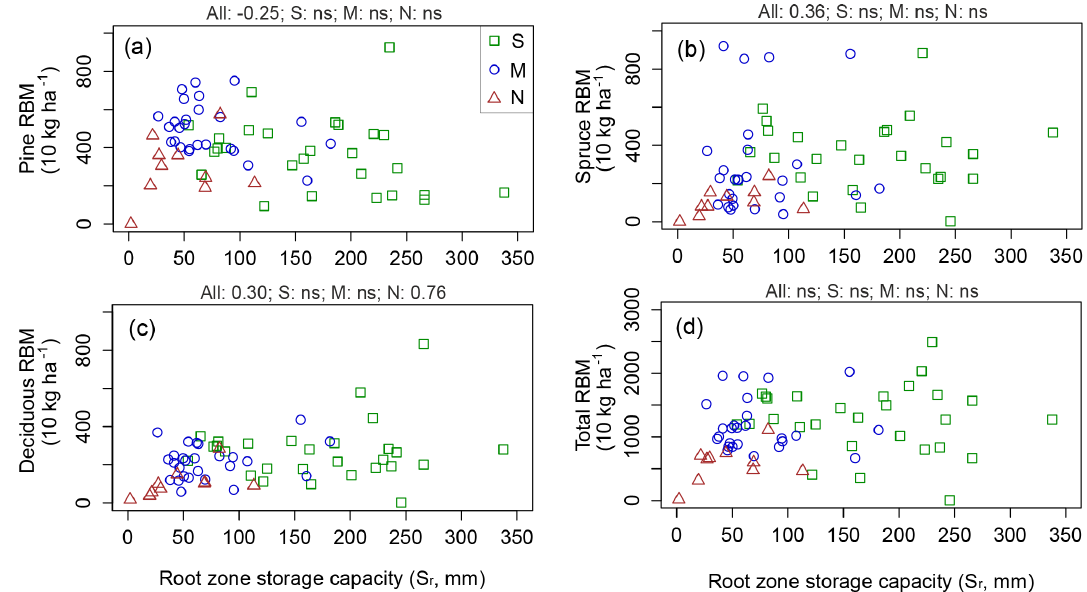
Figure 5. Root zone storage capacities and (a) pine root biomass (RBM, 10kgha − 1 ), (b) spruce RBM (10kgha − 1 ), (c) deciduous RBM (10kgha − 1 ) and (d) total RBM (10kgha − 1 ) in the catchment at different ecoregions (S is south boreal, M is mid-boreal and N is north boreal). The titles of the sub-plots show the Spearman’s correlation coefficients (significant correlation for p < 0 . 05).